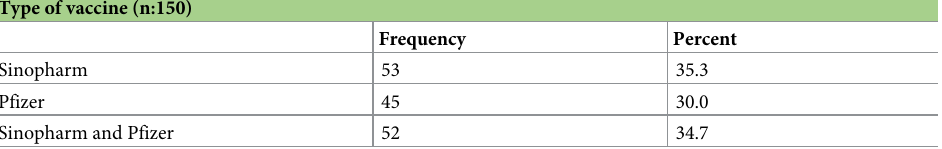
Table 2. Type of vaccines